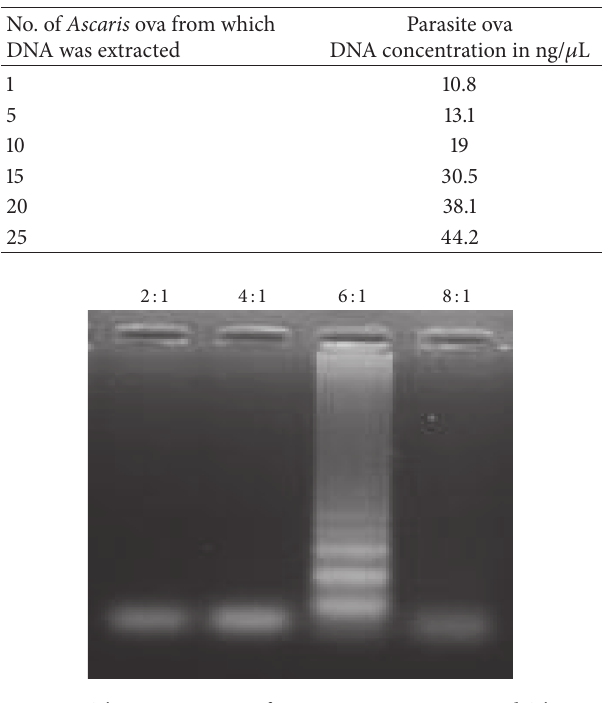
Figure 1: The various ratio of inner: outer primers tested. The 6 :1 ratio readily amplified DNA of adult A. lumbricoides worm (positive control).